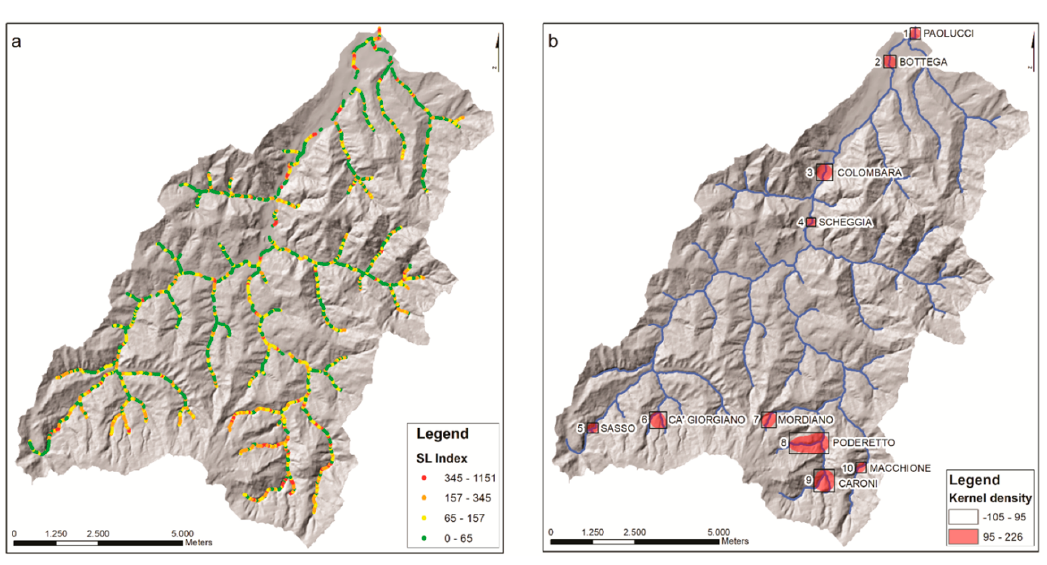
Figure 7. Maps derived by the application of SLiX model and SL-HCA model within the Apsa river catchment. ( a ) SL point map; ( b ) kernel density raster map.